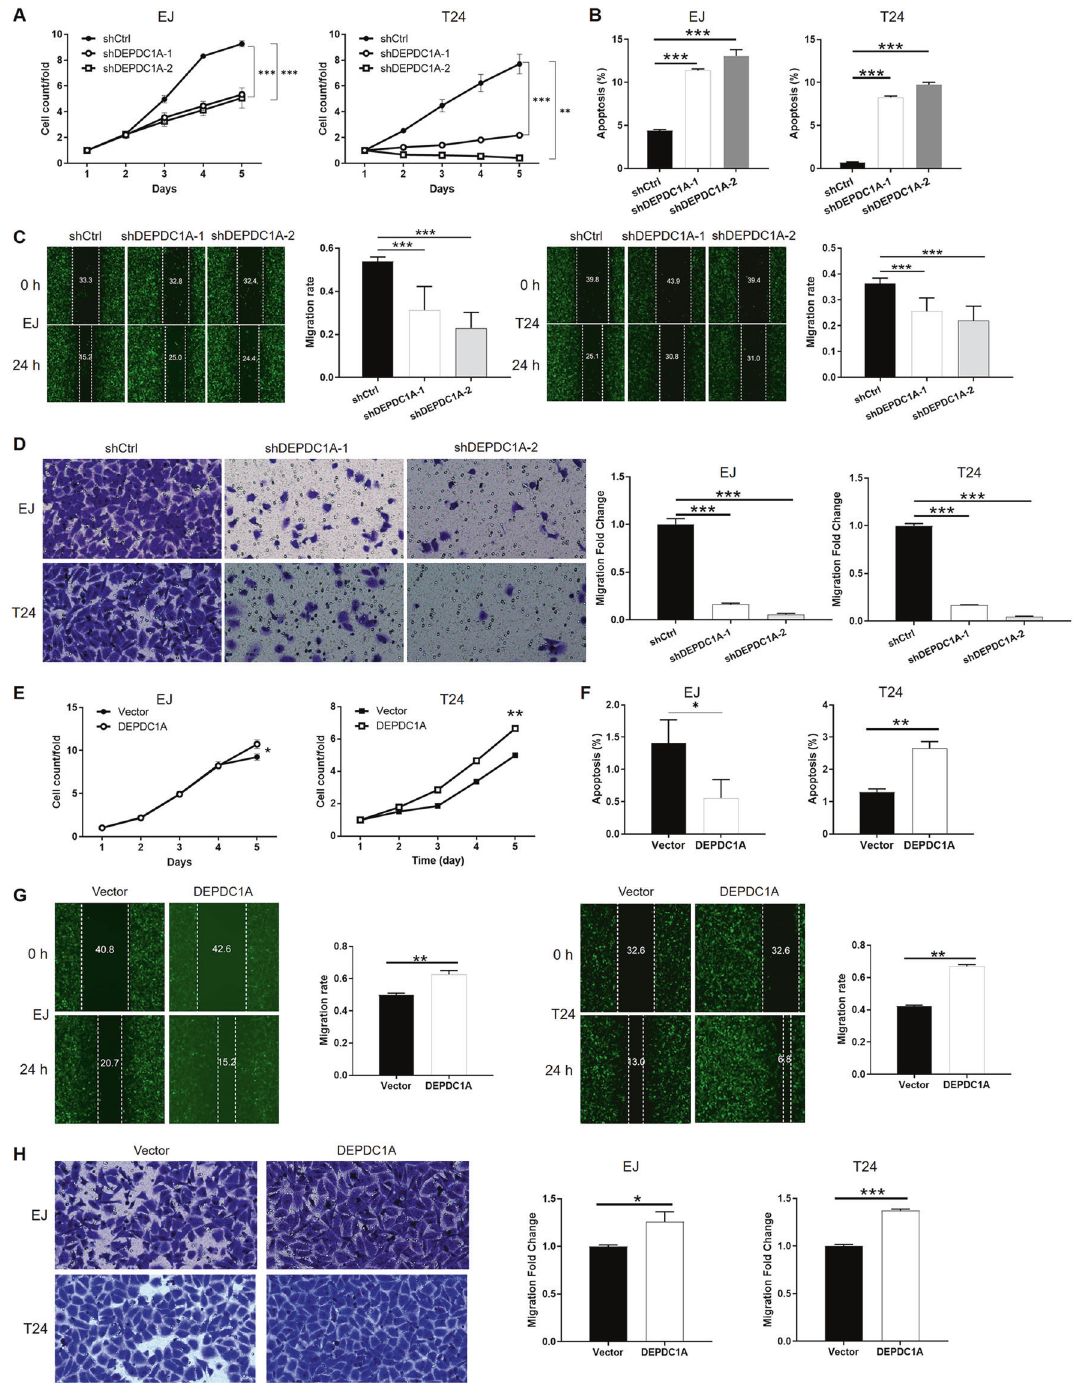
Fig. 5 DEPDC1A regulated bladder cancer development in vitro. A , E Celigo cell counting assay was employed to show the effects of DEPDC1A on cell proliferation of EJ and T24 cells. B , F Flow cytometry was performed to detect cell apoptosis of EJ and T24 cells with or without DEPDC1A knockdown ( B )/overexpression ( F ). C , D , G , H The effects of DEPDC1A on cell migration ability of EJ and T24 cells were evaluated by wound-healing assay ( C , G ) and Transwell assay ( D , H ). The representative images were selected from at least three independent experiments. Data were shown as mean ± SD. * P < 0.05, ** P < 0.01, *** P <